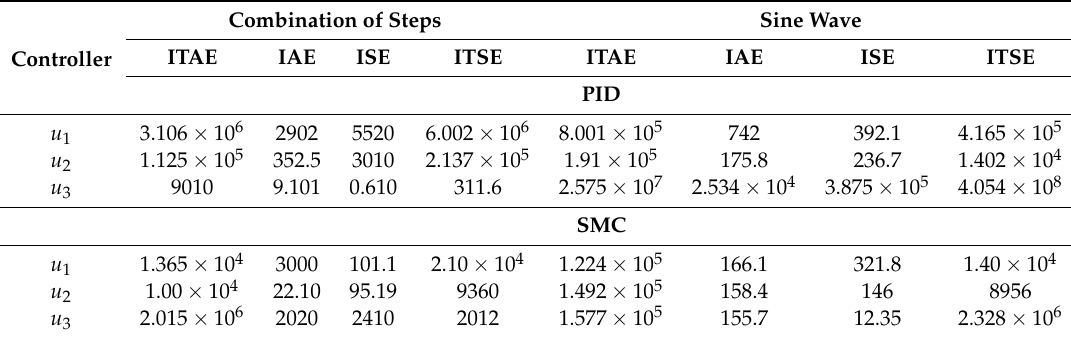
Table 5. Performance indices values of u 1 , u 2 and u 3 for both SMC and the PID controller. ITAE, integral time absolute error; IAE, integral of absolute error; ISE, integral of squared error; ITSE, integral time squared